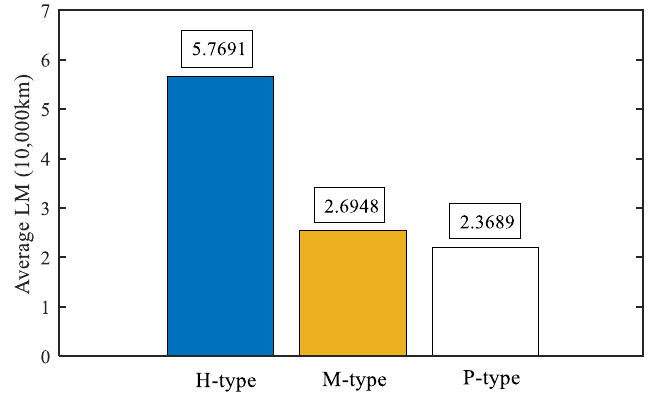
Figure 5. Average LM histogram of the three types of PCCS.